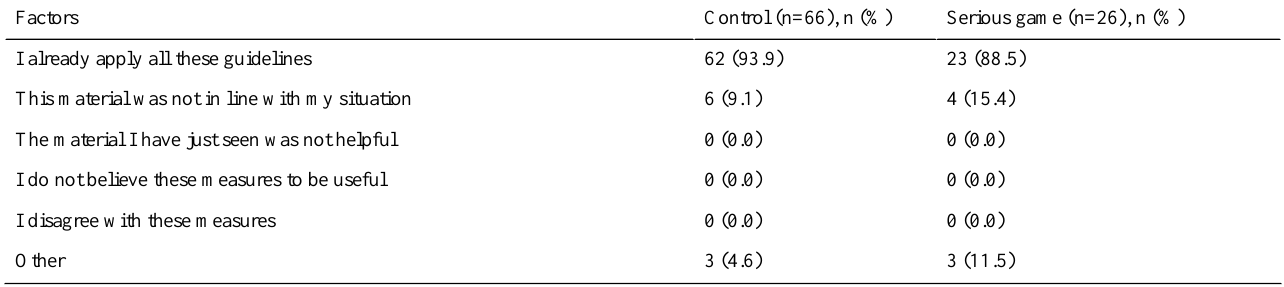
Table 3. Factors underlying the lack of willingness to change infection prevention and control behavior.